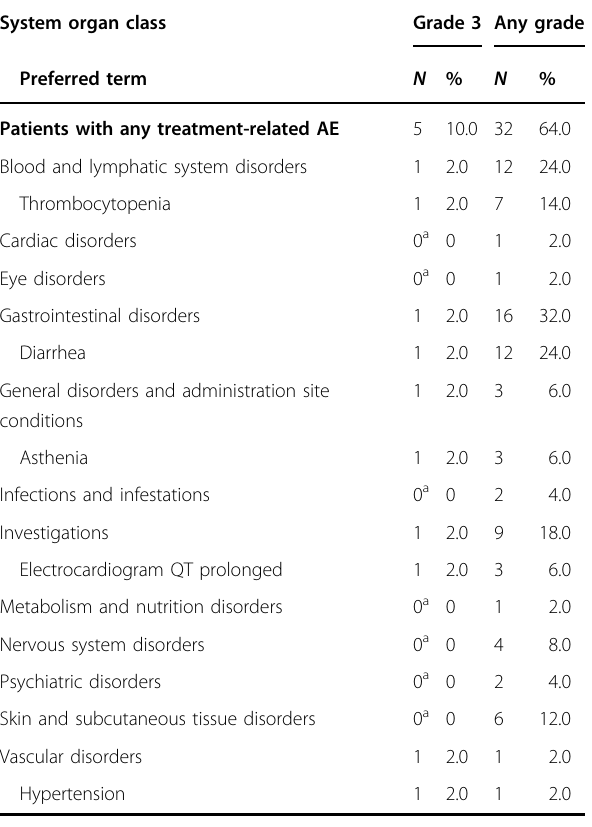
Table 2 Patients with study drug-related AEs during the long-term study, overall and by system organ class and preferred term (including only preferred terms reported by one or more patient with Grade >2 events).